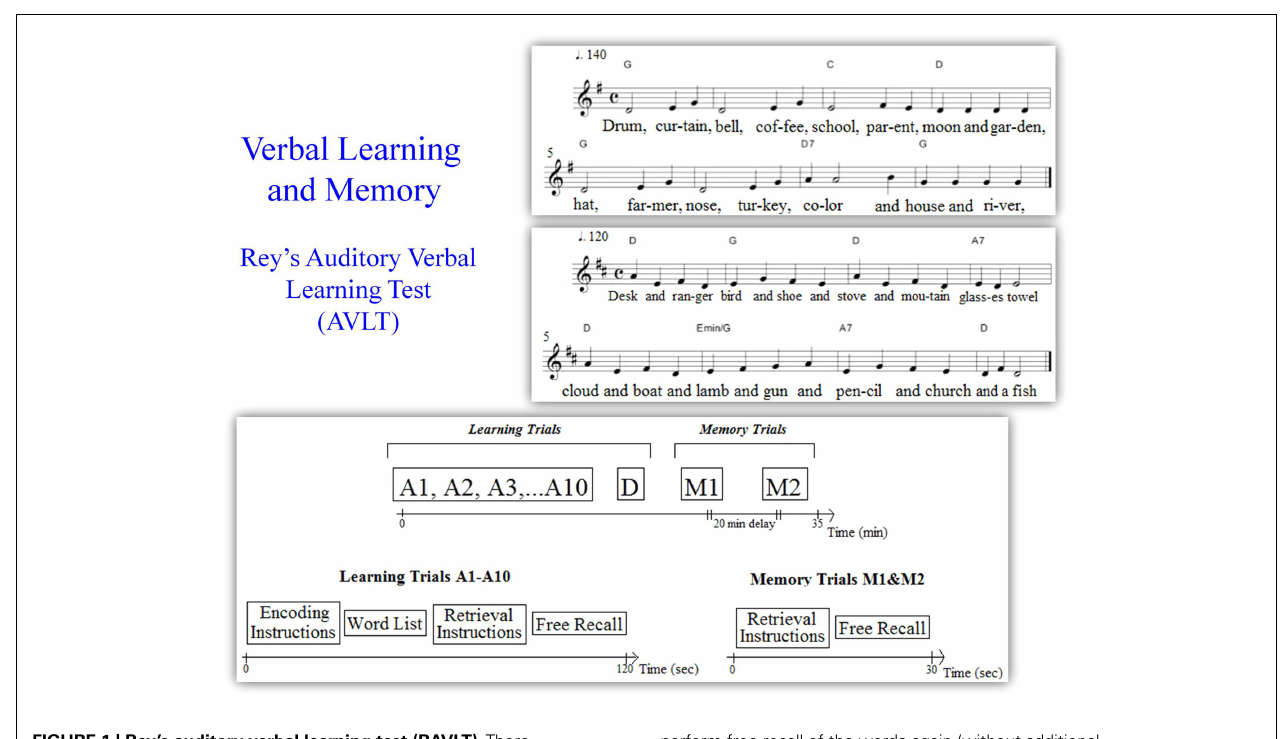
FIGURE 1 | Rey’s auditory verbal learning test (RAVLT) .There were 10 presentations of the same word list and one presentation of a new distractor word list. On each trial, subjects hear the full list of 15 words before being prompted to recall. Subjects are asked to